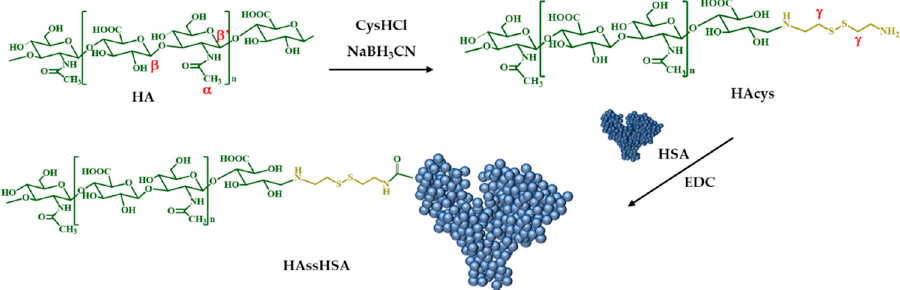
Figure 1. Synthesis of HAcys and HAssHSA conjugate.